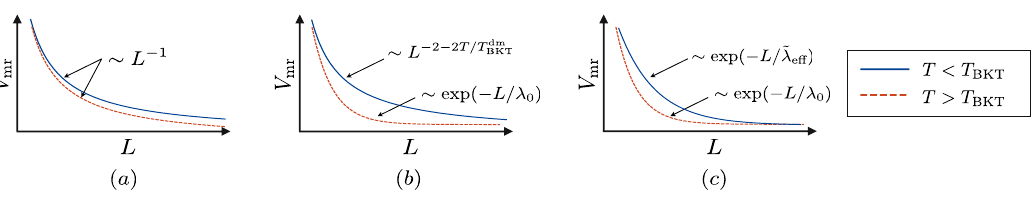
Figure 4: Schematic illustrations of the length dependence of the voltage magnetore- ≡ ∆ V ( p = − p = p ) − ∆ V ( p = p = p ) below and above the BKT tran- sistance V l r l r mr sition temperatures driven by proliferations of (a) full-quantum vortices [ Eq. (10) ] , (b) d -vector merons [ Eqs. (11, 12) ] , and (c) half-quantum vortices [ Eqs. (14, 15) ] . See the main text for detailed